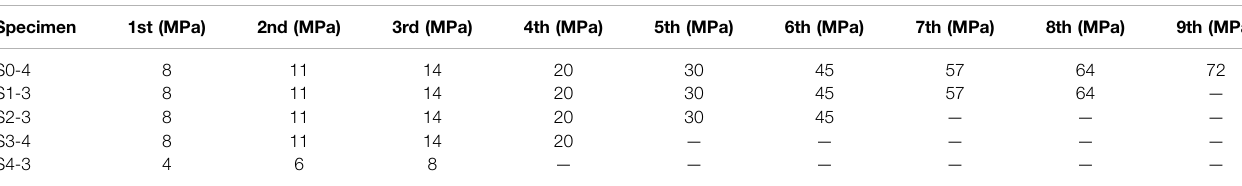
TABLE 2 | Rheological loading stress level statistics of specimens. Specimen